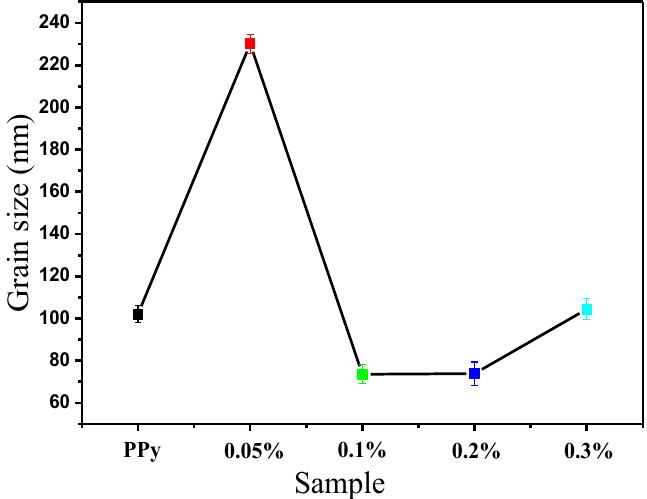
Fig. 3. Grain size graph of pure PPy and NiO-PPy nanocomposites Fig. 3